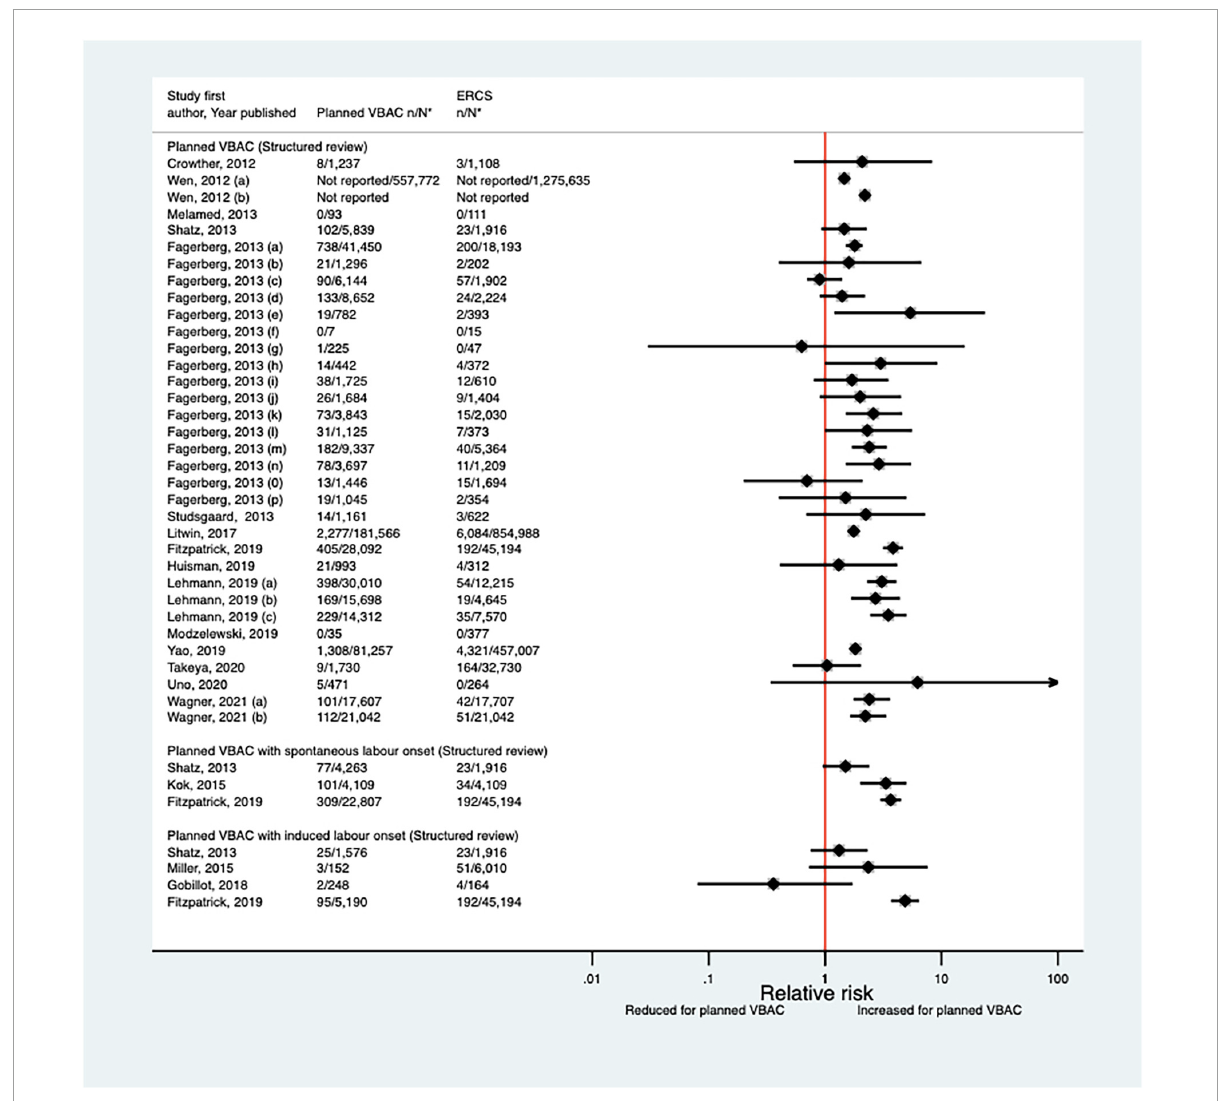
FIGURE14 Risk of Apgar score < 7 at 5 min after birth for planned VBAC vs. ERCS. ∗ n , number in group with the outcome; N , Total number in group. Wen et al. (42) (a) risk in total study population, (b) risk in infants born to “low-risk” women without pre-existing medical problems, pregnancy complications, preterm birth or an infant with low birth weight or congenital anomaly; Fagerberg et al. (43) (a) risk in all women with one prior CS, (b) risk in women whose indication for first CS multiple gestation, (c) risk in women whose indication for first CS preterm birth, (d) risk in women whose indication for first CS breech or other malpresentation ≥ 37 weeks’ gestation, (e) risk in women whose indication for first CS significant congenital malformation, (f) risk in women whose indication for first CS rupture of uterus, (g) risk in women whose indication for first CS placenta praevia, (h) risk in women whose indication for first CS diabetes mellitus/gestational diabetes, (i) risk in women whose indication for first CS small for gestational age/suspected intrauterine growth restriction, (j) risk in women whose indication for first CS large for gestational age/suspected large for gestational age/birth weight > 4,500 g, (k) risk in women whose indication for first CS prolonged pregnancy ≥ 42 weeks’ gestation, (l) risk in women whose indication for first CS severe pregnancy complications/severe maternal disease, (m) risk in women whose indication for first CS complications during labor/birth, (n) risk in women whose indication for first CS fetal distress/death unexplained by indications above, (o) risk in women whose indication for first CS no indication listed above/mild conditions not classified elsewhere, (p) risk in women who had no diagnosis available for indication for first CS; Lehmann et al. (67) (a) risk in all of study population, (b) risk in “low-risk” women, (c) risk in “high-risk” women. Wagner et al. (77) (a) Risk in women with no prior vaginal births. (b) Risk in women with ≥ 1 prior vaginal birth. CS, cesarean section; ERCS, elective repeat cesarean section; VBAC, vaginal birth after previous